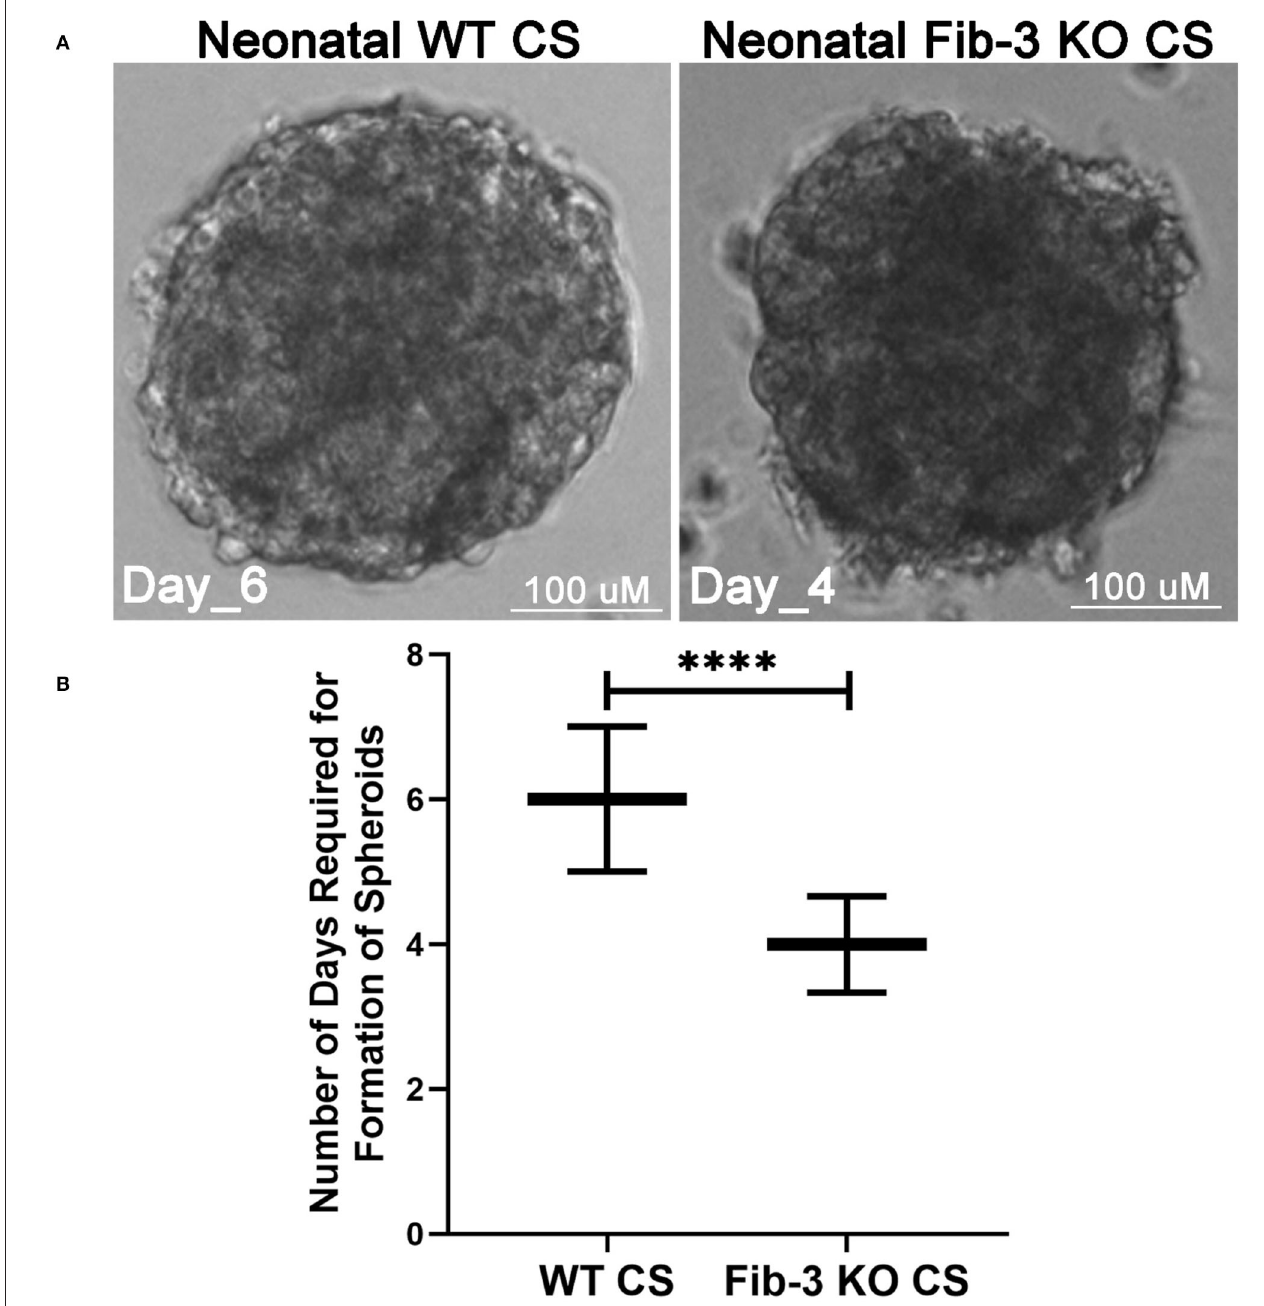
FIGURE 1 | Fib-3 KO CSs form faster than WT CSs. (A) Representative images of WT and Fib-3 KO CSs at day 4. (B) Statistical analyses of CS formation in WT vs. Fib-3 KO CSs. Unpaired t- test, p < 0.0001 = **** . Error bars represent the mean ± SD ( n = 384). 24 h), followed by hypoxia (0% O 2 , 20 h), followed by normoxia (5% O 2 , 17 h) in an EVOS FL Auto Live imaging system (Life Technologies) to induce I/R injury in CSs (1). Control CSs were kept in the incubator in normoxic conditions for the whole duration of the procedure (24 + 20 + 17 h) and stained with image-IT to confirm no changes in intracellular O 2